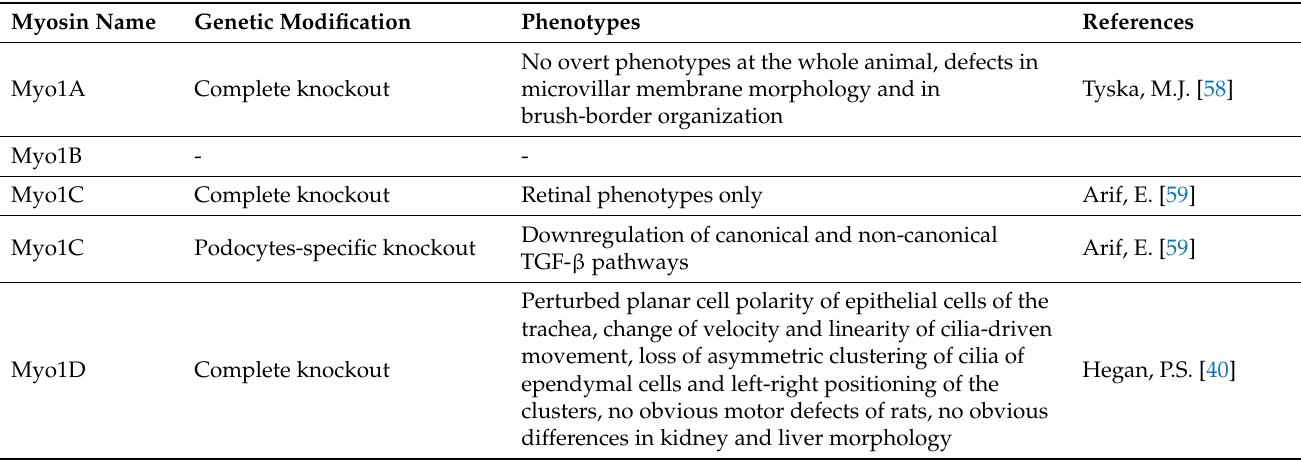
Table 3. Genetic studies and experiments using murine models of